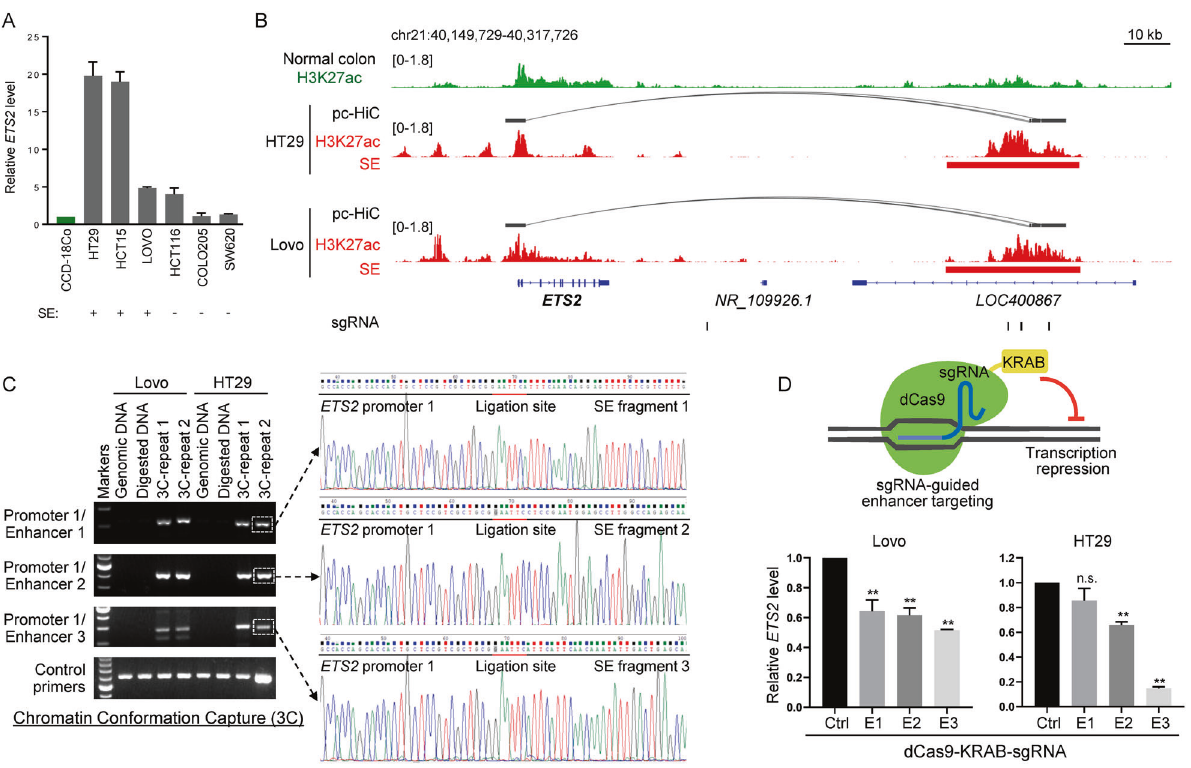
Fig. 2 A distal super-enhancer activates ETS2 transcription through long-range interaction in CRC cell lines. A Expression level of ETS2 in CRC cell lines and a normal colonic epithelial cell line CCD-18Co as determined by RT-qPCR. SE, super-enhancer. B IGV tracks showing the H3K27ac ChIP-seq pro fi les of indicated samples across ETS2 promoter and its potential distal SE. Bridging curves indicate the interactions between the distal SE and ETS2 promoter detected by pc-HiC experiments in indicated cell lines. The sites targeted by guide RNAs that recruits dCas9-KRAB were indicated at the bottom. C Left panel: PCR results for 3C samples or control samples using primers targeting indicated regions (fragments in ETS2 promoter or its distal SE). A pair of primers that amplifying a region nearby ETS2 promoter that does not contain any EcoRI restriction site inside were used as positive controls. Right panel: Sanger sequencing results of indicated PCR products from 3C experiments. D Upper panel: diagram showing the principle of the dCas9-KRAB targeted transcription repression system. Bottom panel: expression level of ETS2 in cells expressing sgRNAs targeting indicated enhancer fragments or a control intergenic region together with the dCas9-KRAB fusion protein. ** p < 0.01; n.s. non-signi fi